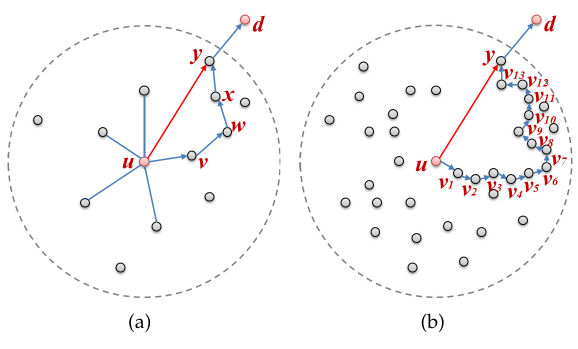
Figure 2. Face routing according to the node density: ( a ) a low density network; and ( b ) a high density